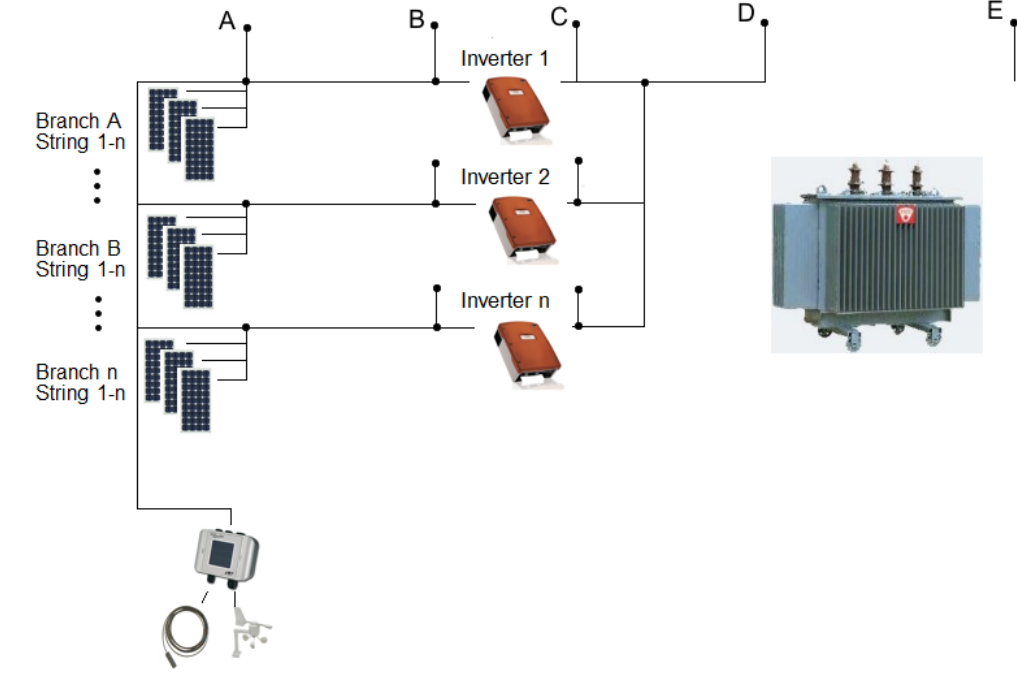
Figure 4. Scheme of the monitoring points.